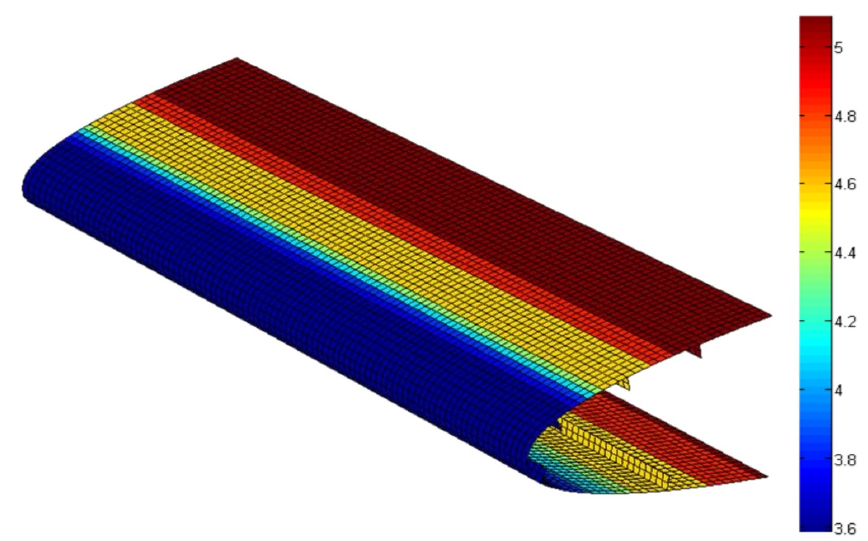
Figure 5. Optimized distribution of thickness in millimeters. All stringer thicknesses were set at 7.625